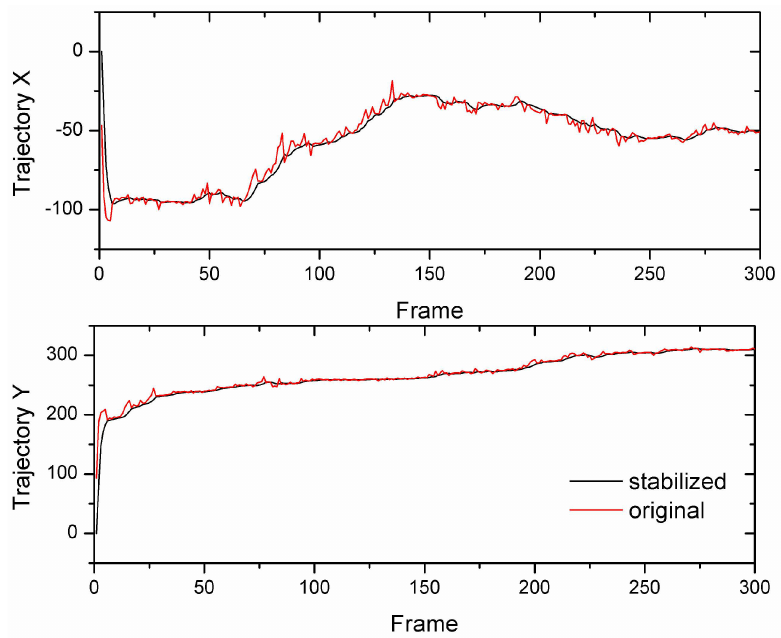
Figure 13. The smooth trajectory from Kalman filter in the video of Sequence